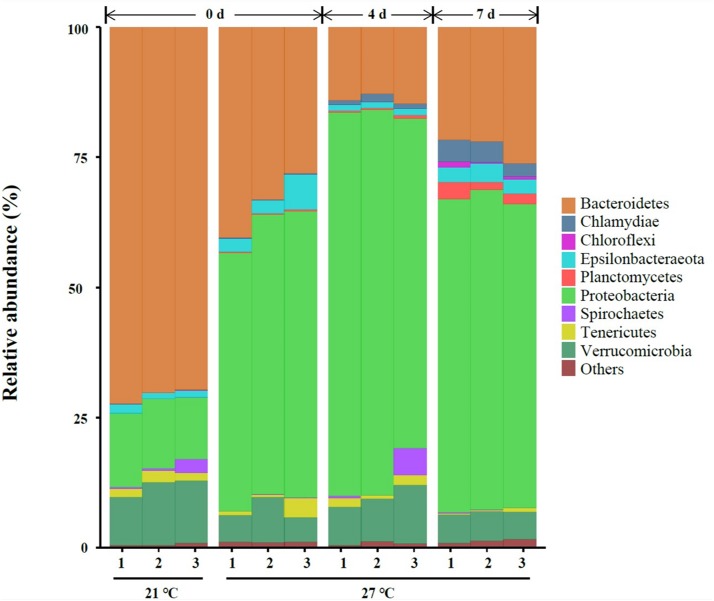
Relative abundance of bacterial communities at the phylum level of gut samples. Three replicates are labeled with the numbers 1, 2, and 3.